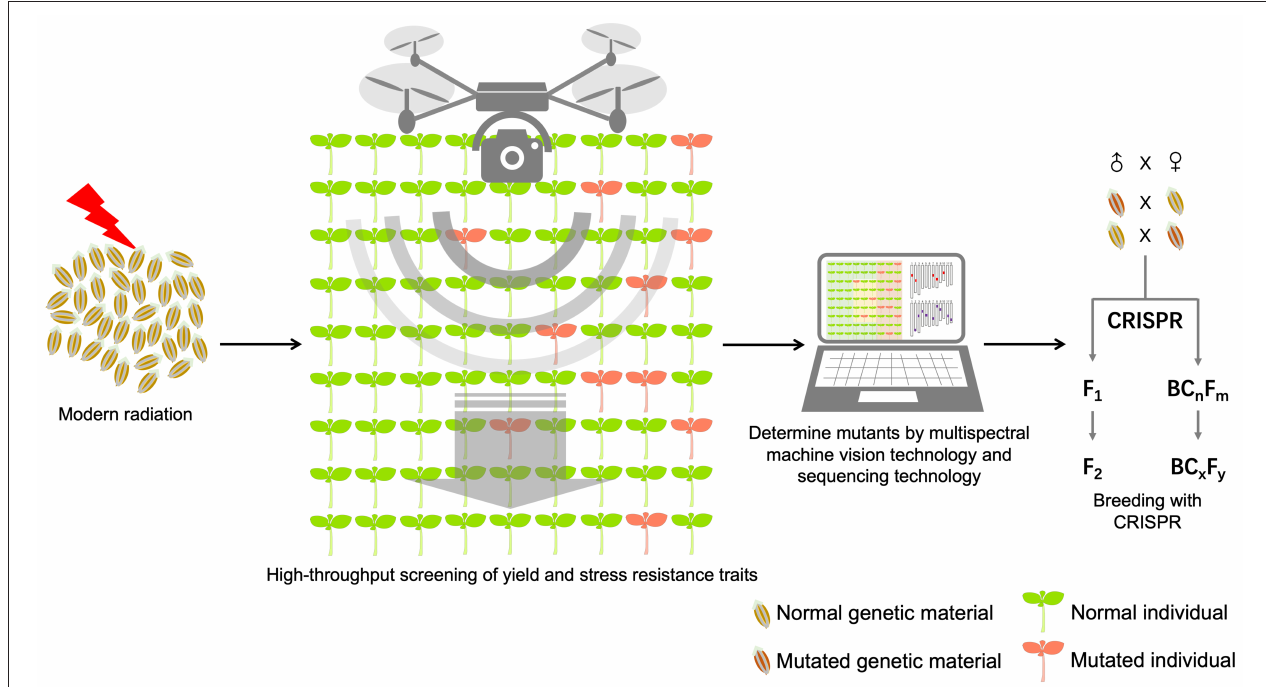
FIGURE 4 | Next-generation effective modern particle radiation and high-throughput screening combined breeding system.